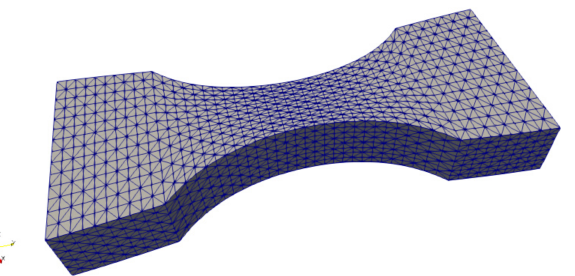
Figure 1. Finite-element mesh of the structure considered in this